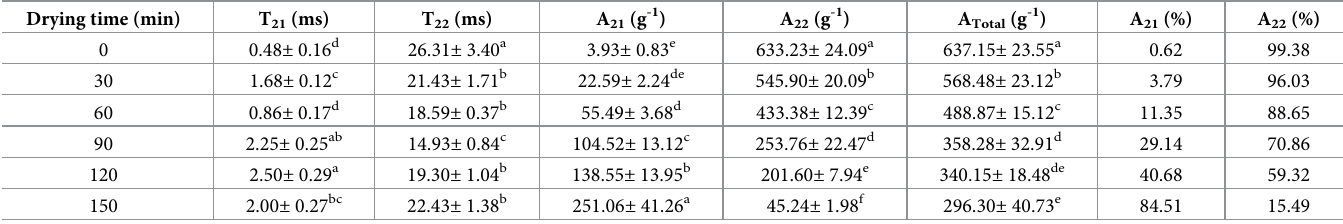
Table 2. Changes in signals per unit mass of AR pieces during hot-air drying at 80˚C.